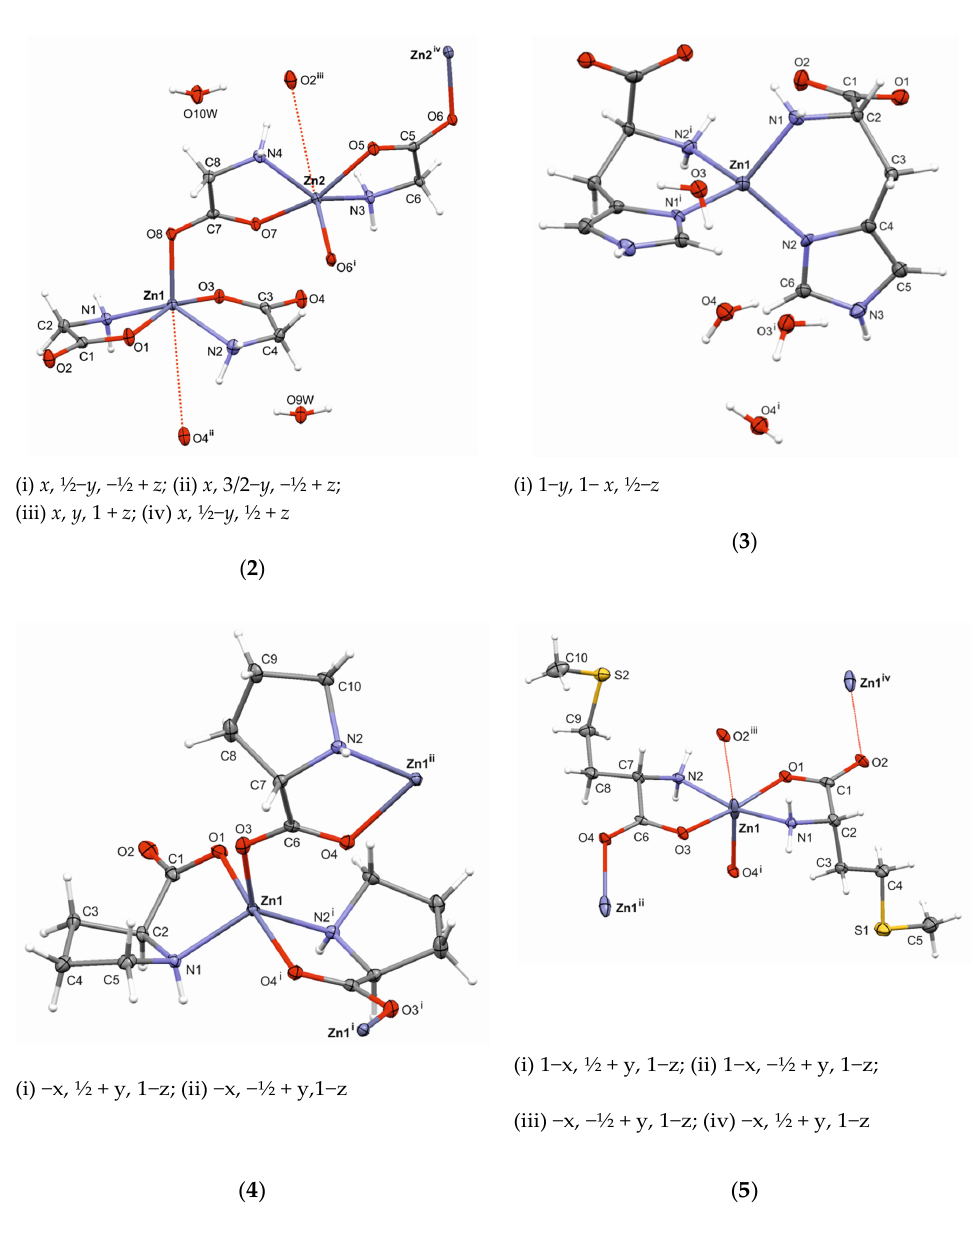
Figure 1. The molecular structures of Zn(II) complexes with glycine ( 2 ), L-histidine ( 3 ), L-proline ( 4 ), and L-methionine ( 5 ), showing the atom-numbering scheme. Displacement ellipsoids are drawn at the 50% probability level and hydrogen atoms are shown as small spheres of arbitrary radii.